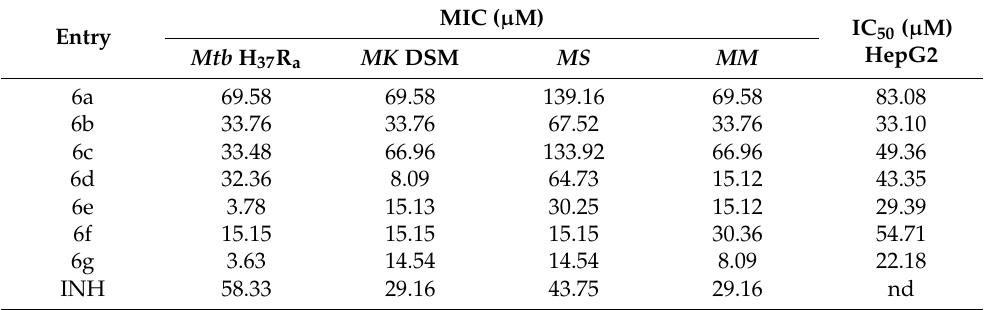
Table 3. The in vitro biological evaluation of the 6a – g set and isoniazid (INH) reference drug including their activity (MIC values, in µ M units) against M. tuberculosis H 37 R a ATCC 25177 ( Mtb H 37 R a ), M. kansasii DSM 44162 ( MK DSM), M. smegmatis ATCC 700084 ( MS ), and M. marinum CAMP